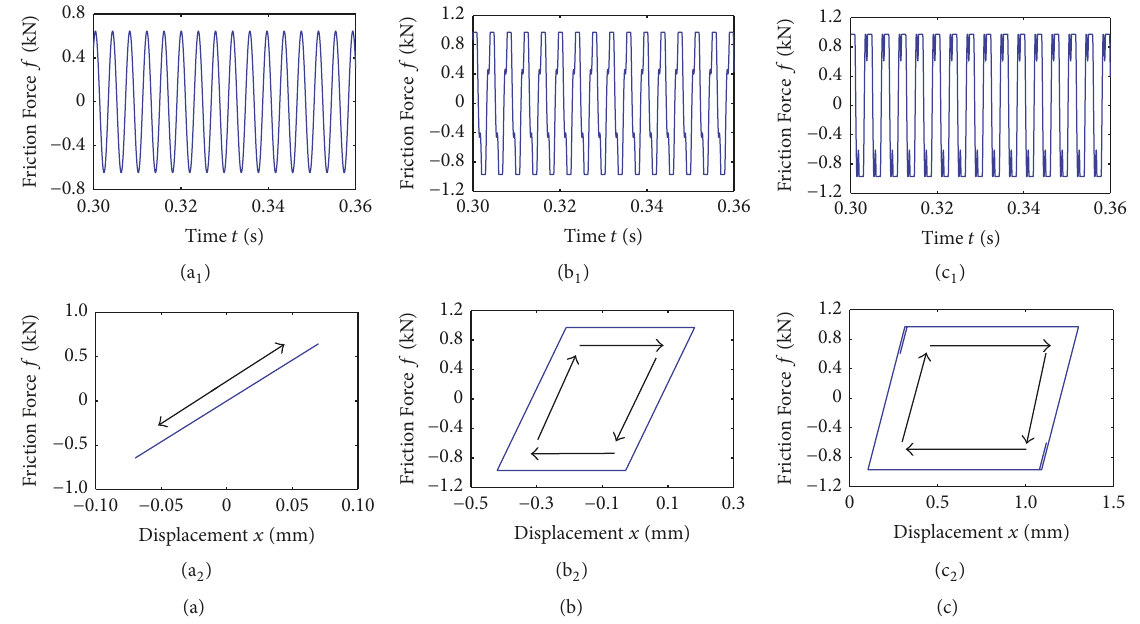
Figure 11: The variation curves of dry friction force at different excitation amplitudes (subscript 1 represents the variation curve of dry friction force and subscript 2 represents the hysteresis